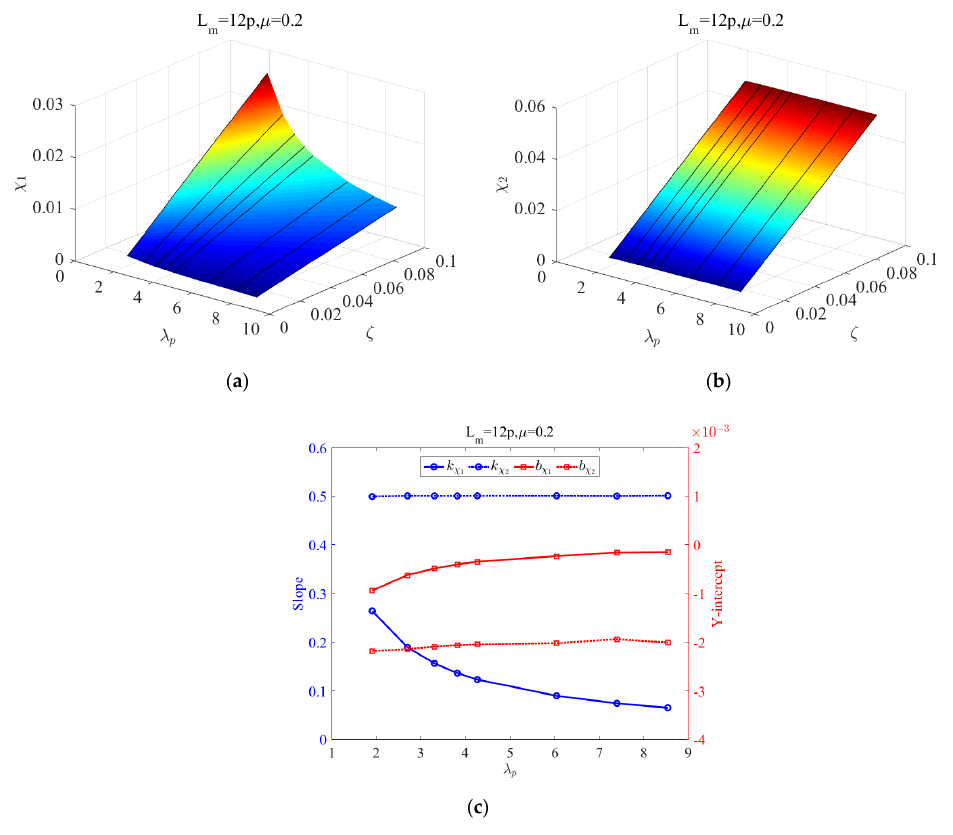
Figure 13. Three-dimensional plot of fitting coefficient of deflection curve for strands with different axial tension: ( a ) χ 1 − ζ − λ p and ( b ) χ 2 − ζ − λ p ; ( c ) the slope and intercept of χ i − ζ line for 12-pitch-long strand with friction coefficient